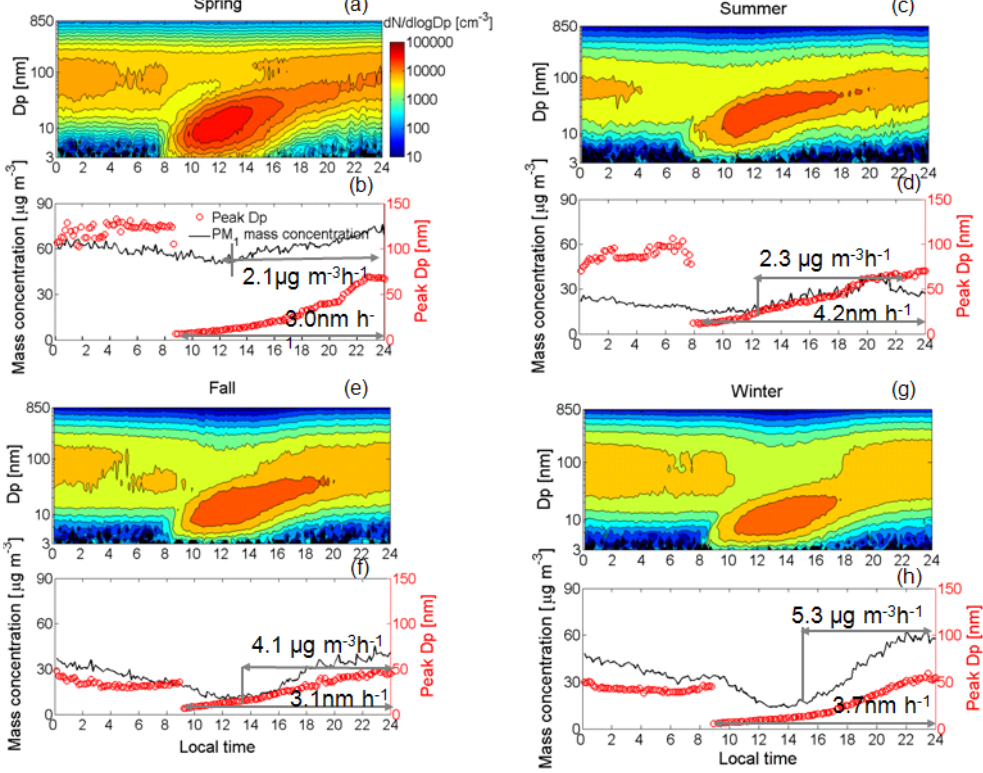
Fig. 10. The evolutions of the particle size distributions (a) , (c) , (e) , (g) , PM 1 mass concentration derived from number size distributions and mean diameter of the dominating mode from mode fitting to the average particle size distributions (b) , (d) , (f) , (h) from only new particle formations events in four seasons.